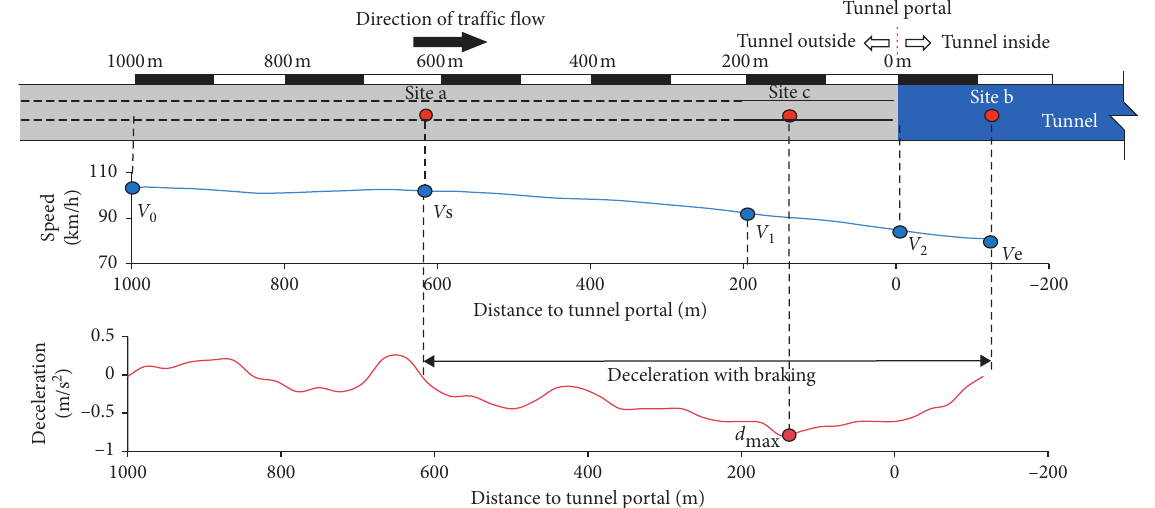
Figure 3: Examples of naturalistic driving data profiles at a tunnel entrance.